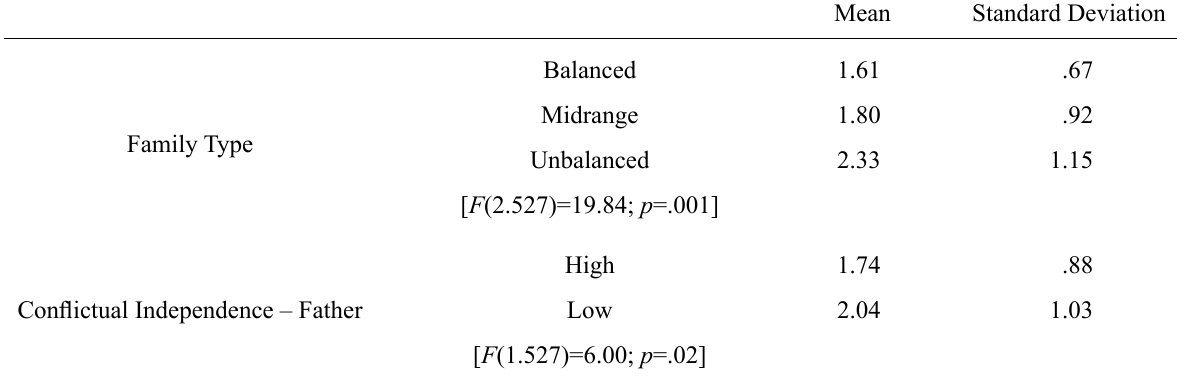
Means of Individuals Concerning the Main Effects of Variables Family Type and Con fl ictual Independence from Father in Suicidal